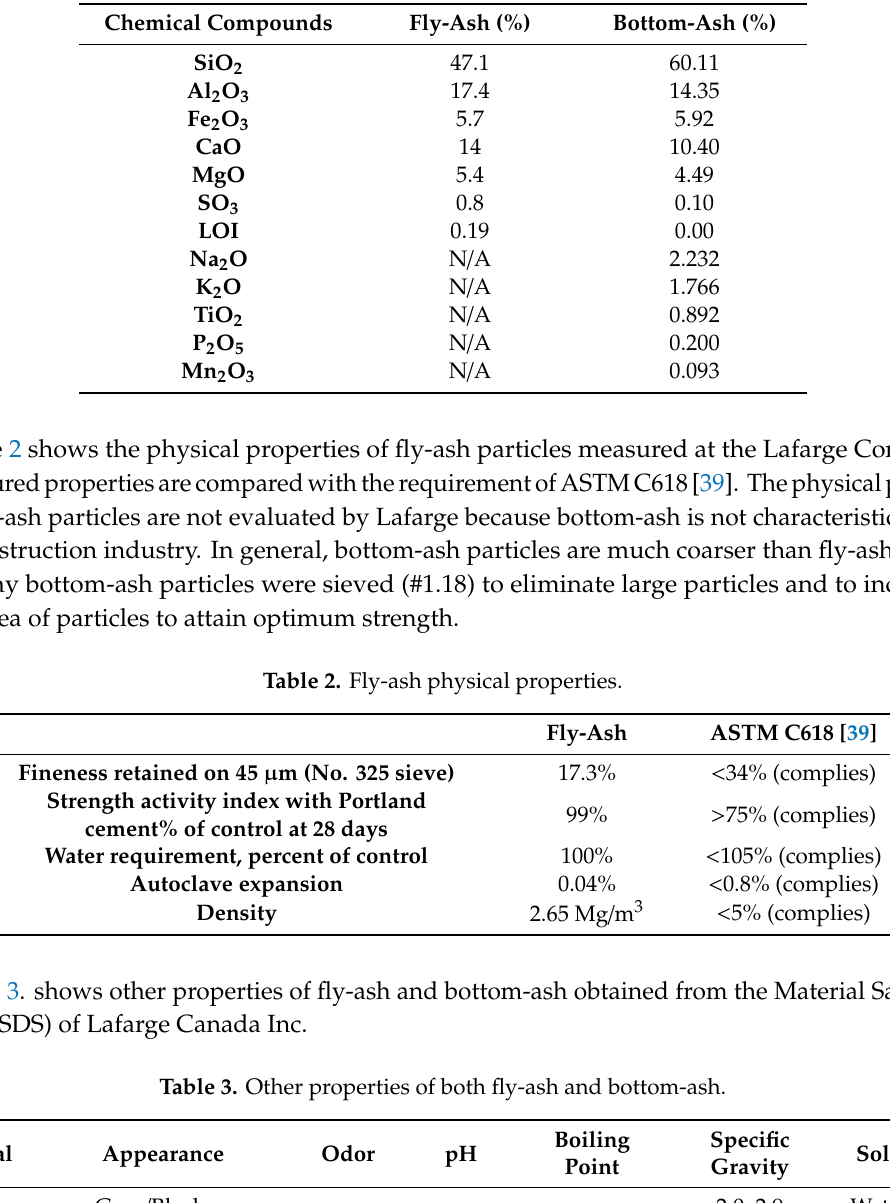
Table 1. Chemical composition of fly-ash and bottom-ash. Source: Lafarge Canada Inc.